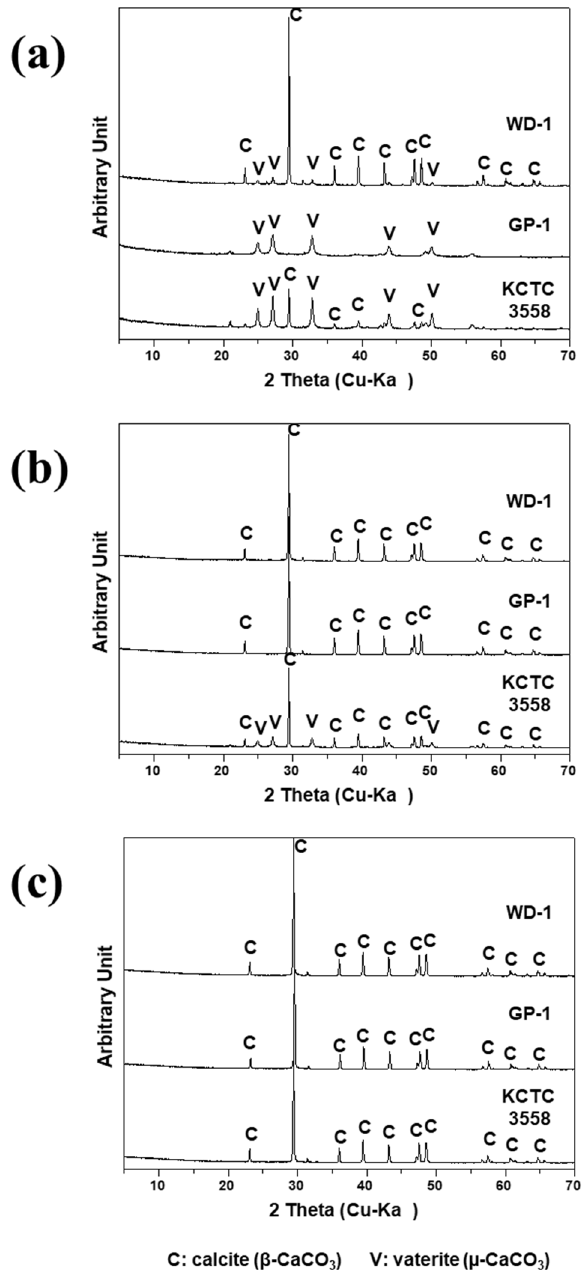
Figure 1. XRD patterns showing Ca-carbonate precipitation in different microbial growth states at ( a ) lag phase or ( b ) stationary phase, and ( c ) the SMP solution without cells.